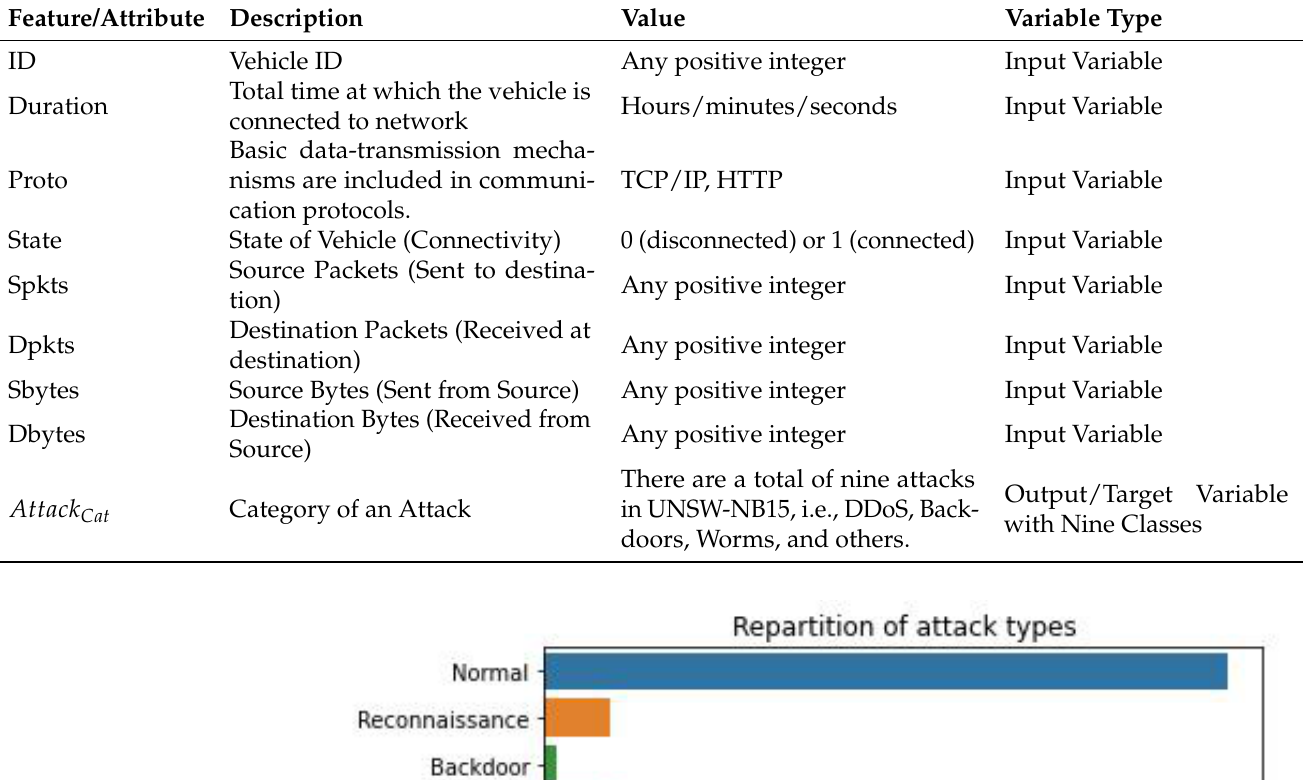
Table 2. UNSW-NB15 dataset description.